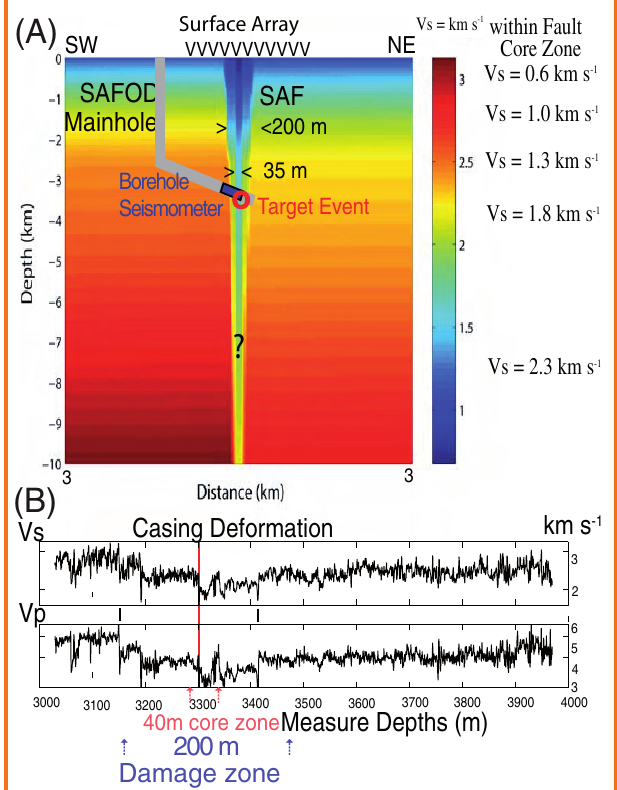
Figure 5. [A] Fault-normal depth section showing the S-wave velocity model across the SAF at the SAFOD site. The velocities within the 100–200-m-wide waveguide on the SAF at seismogenic depths and surrounding rocks were found by 3-D finite-difference fits to the FZTWs generated by explosions and earthquakes at different depths. The model suggests that, on average, a fault zone consists of two vertical layers, a 30–40-m-wide fault core and a surrounding 100–200-m-wide damage zone. S velocities within the damage zone are reduced by 25%–35% from wall-rock velocities. The maximum reduction occurs in the fault core and can be as large as 50%. The red circle denotes the SAFOD drilling target event. The SAFOD mainhole seismogram was installed at ~3 km depth in 2005 (Ellsworth and Malin, 2006). [B] Logging velocities in the SAFOD mainhole show a ~200-m-wide low-velocity damage zone on the SAF at ~3 km depth, in which a ~30–40-m-wide core zone with lowest velocities is embedded. The red line denotes the casing deformation caused in the 2004 M6 Parkfield earthquake (Hickman et al.,